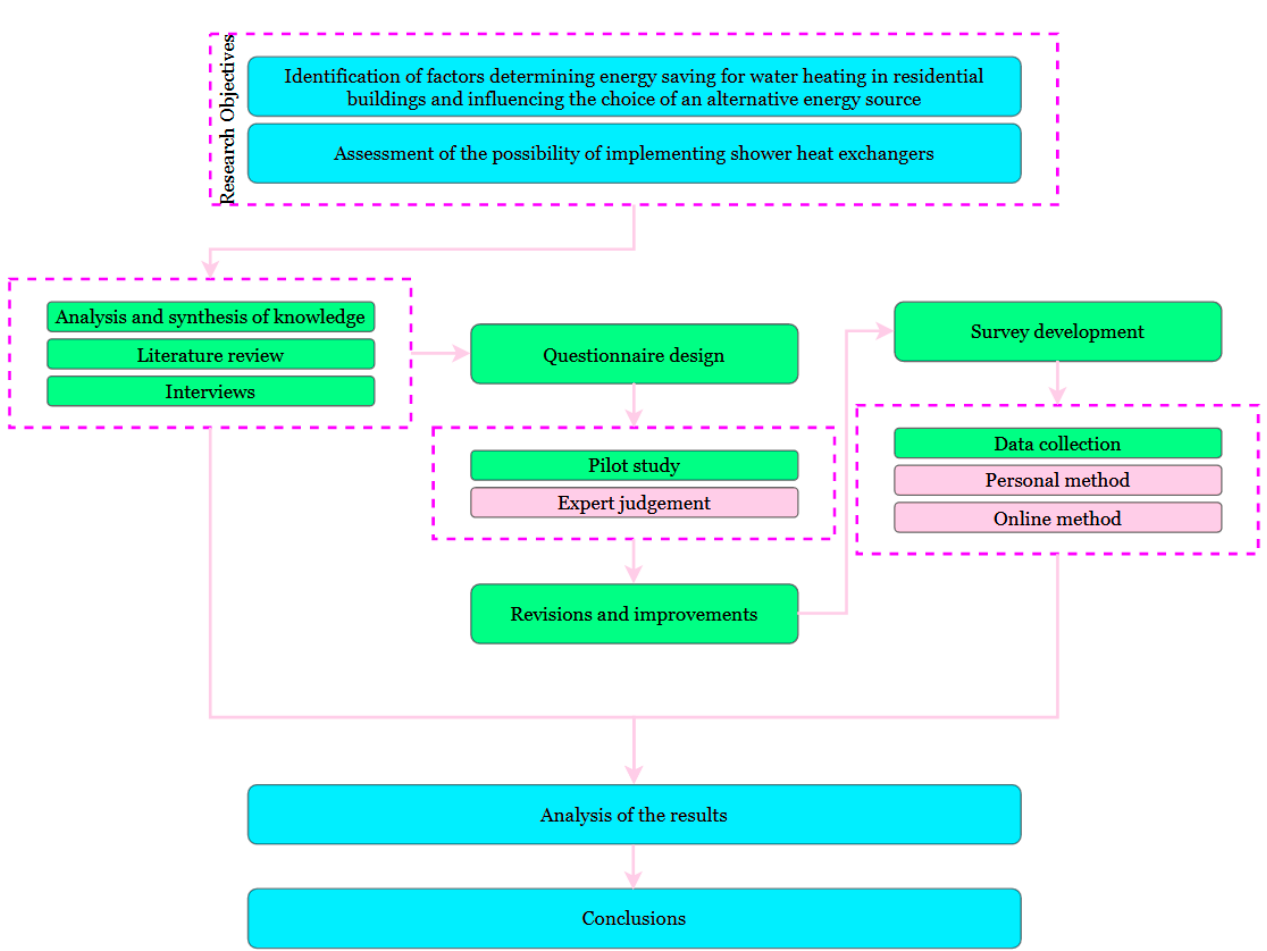
Figure 2. Research plan.